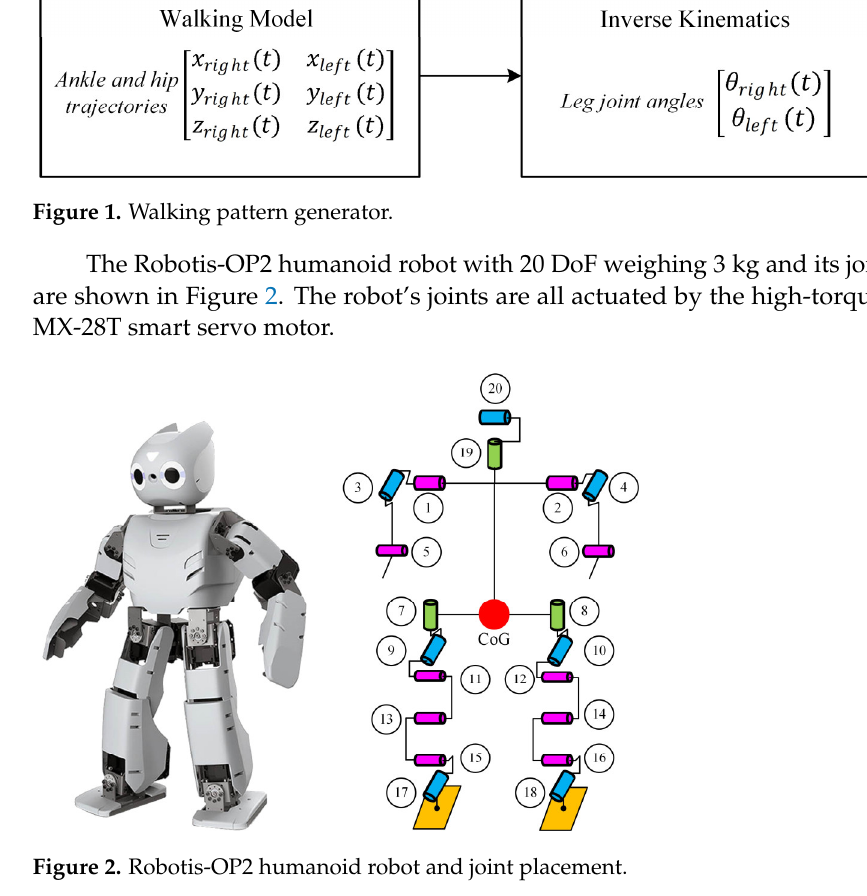
Figure 1. Walking pattern generator.